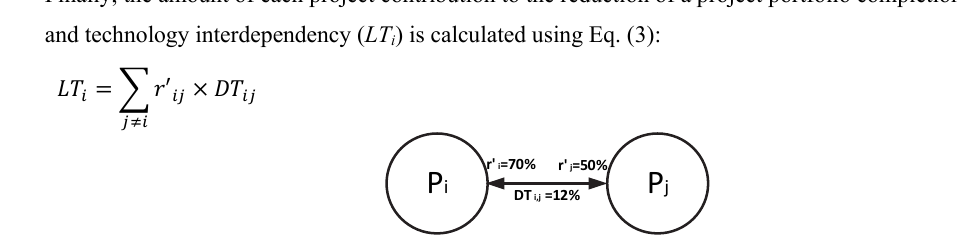
Fig. 2. Graphical view of projects interactions caused by technology transfer and learning